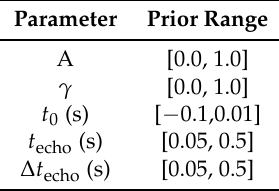
Table 15. Prior range proposed by Lo et al. [145] of the echo parameters of ADA model [18]. Parameter Prior